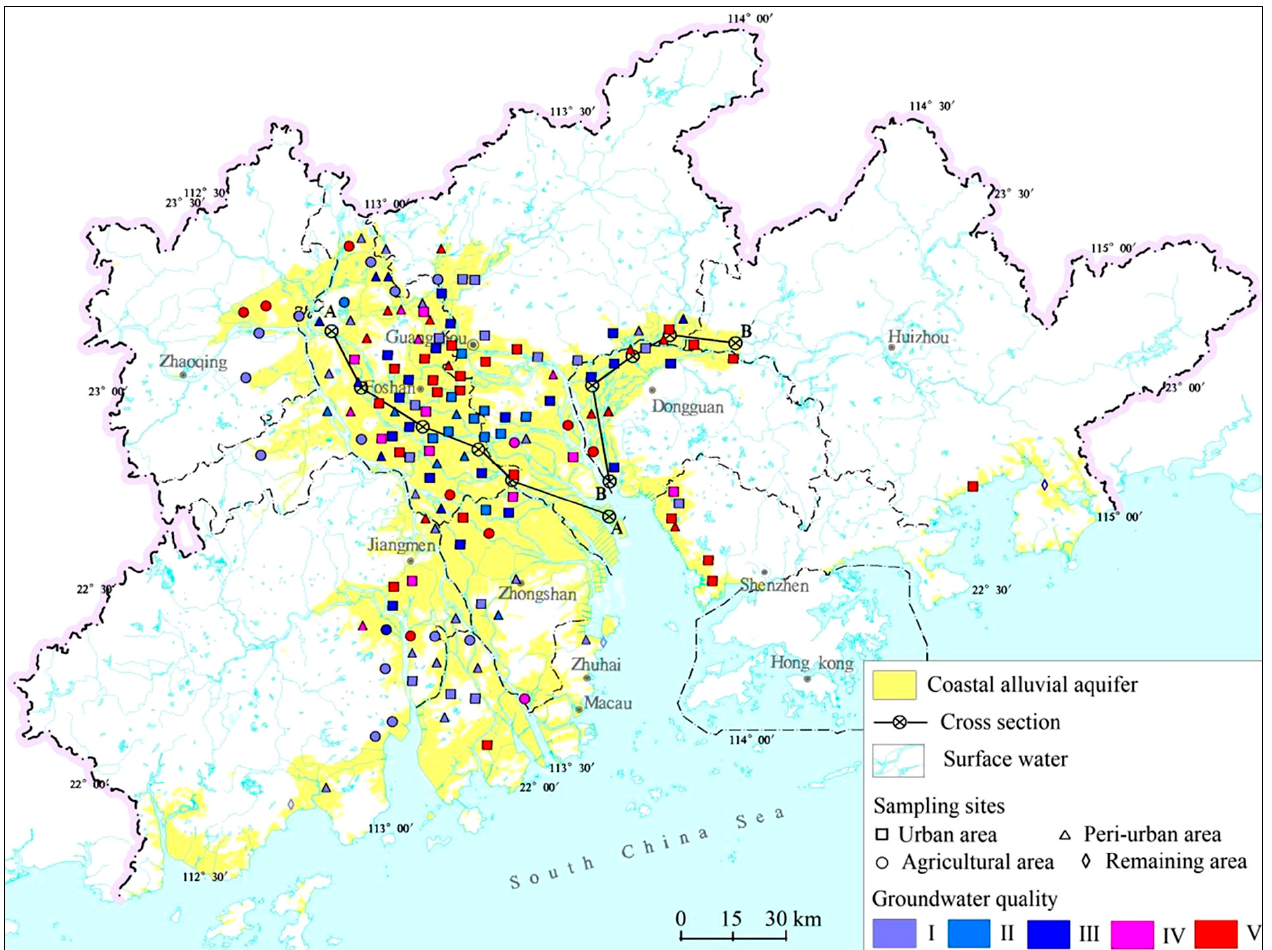
Figure 5. Spatial distribution of groundwater quality in the coastal alluvial aquifer of the Pearl River Delta.